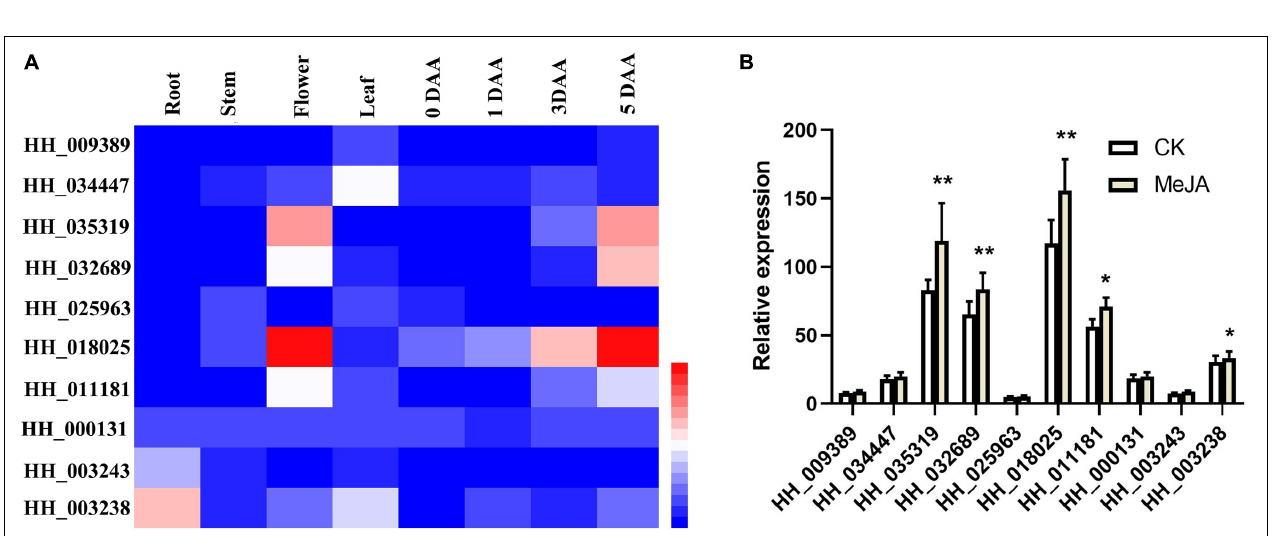
Frontiers in Plant Science |